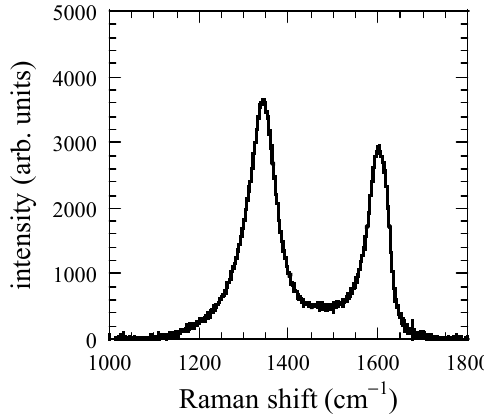
Figure 6. Raman spectrum of CNPs for FR = 50 sccm.